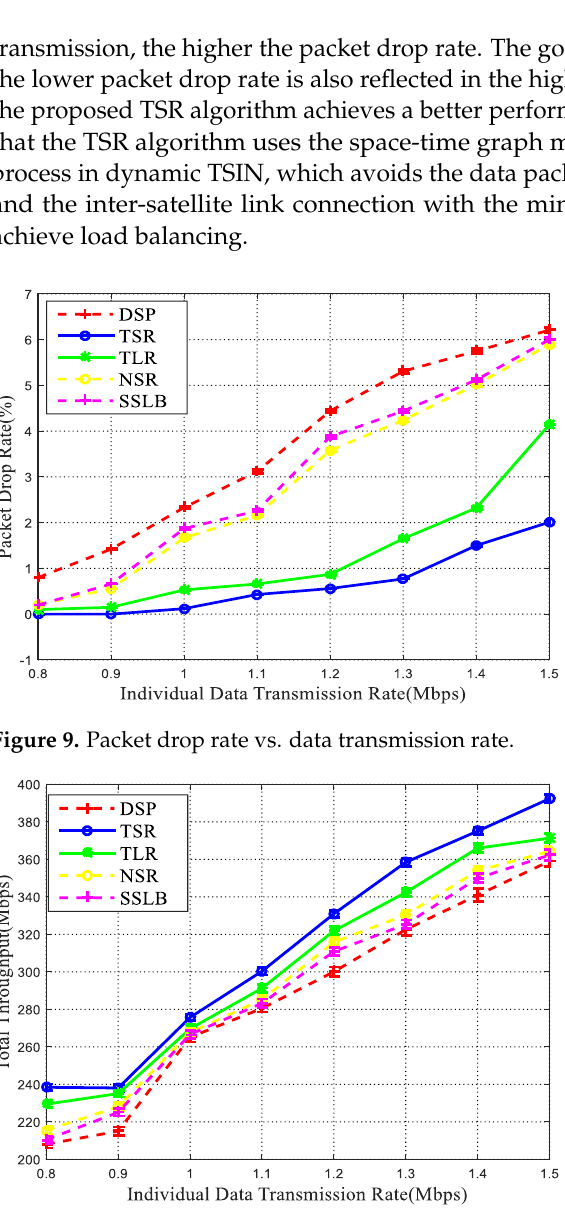
Figure 10. Network throughput vs. data transmission